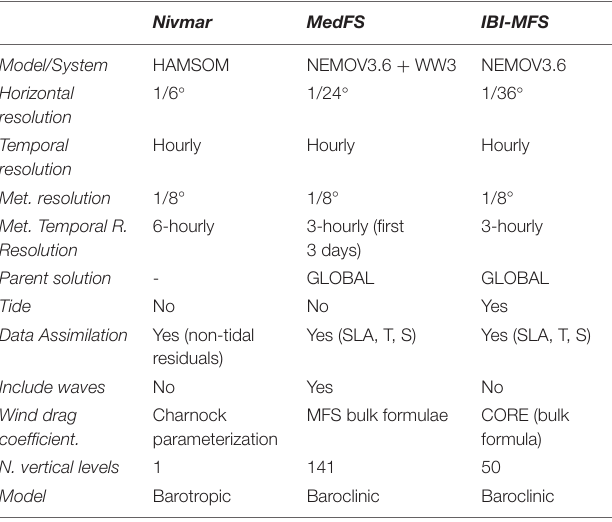
TABLE 1 | Basic information of the different models providing a sea level solution that have been analyzed for the storm